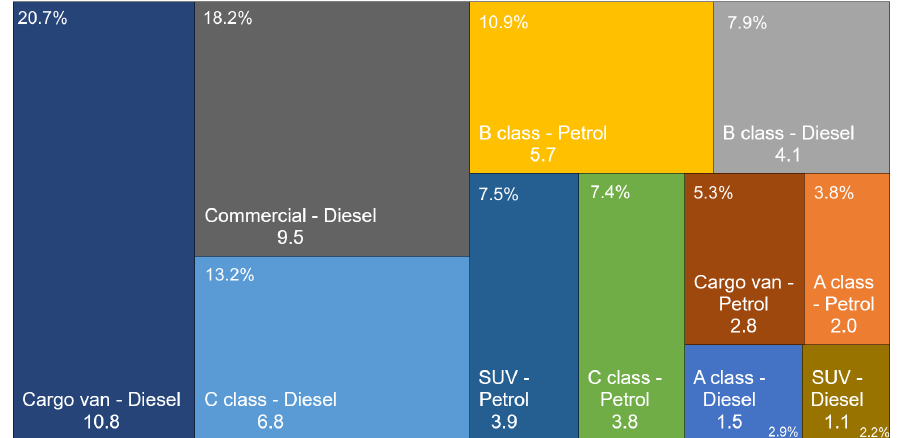
Figure 3. Average monthly fuel consumption for each category of ICE fleet, thous. dm 3 .